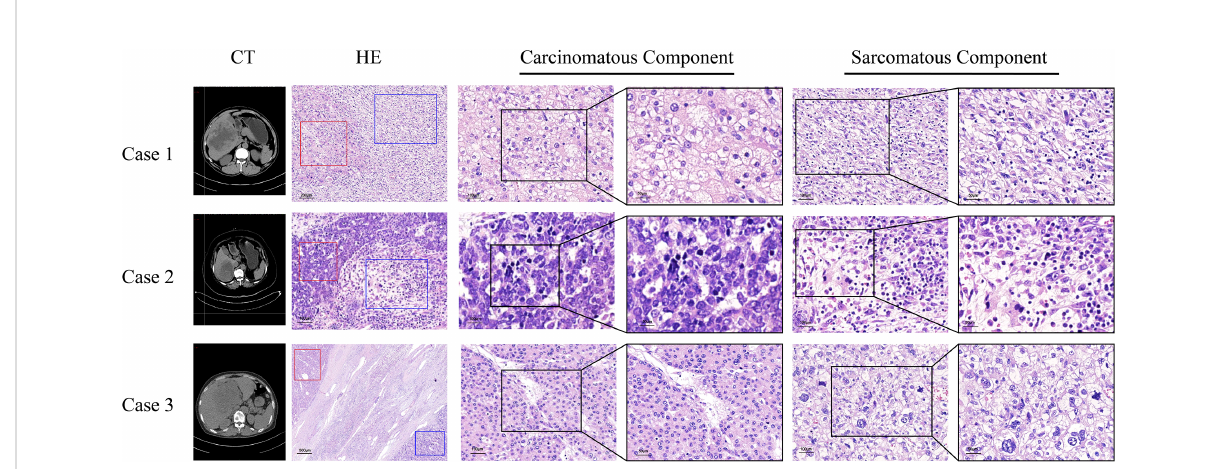
FIGURE 1 Computed tomography scans, the morphology of sarcomatous components and carcinomatous components in the tissues of three HCS cases. Red frames represent carcinomatous components and blue frames represent sarcomatous